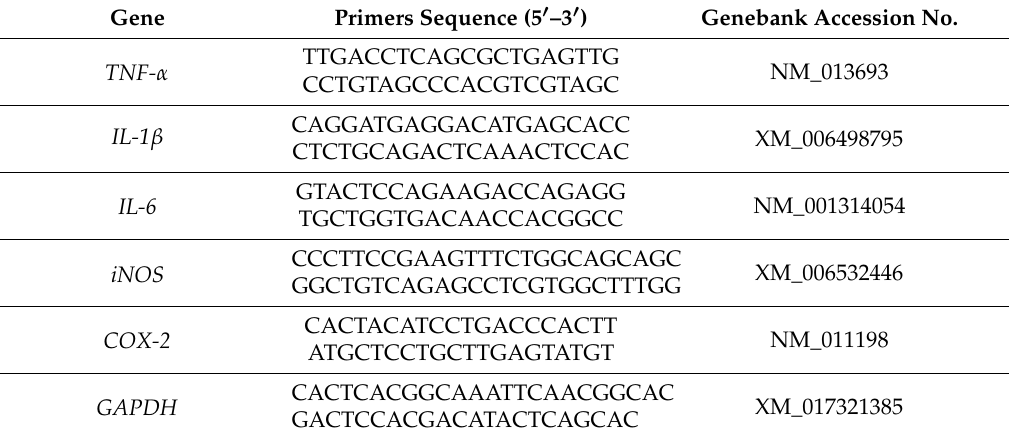
Table 2. The nucleotide sequence of the primers for qPCR.